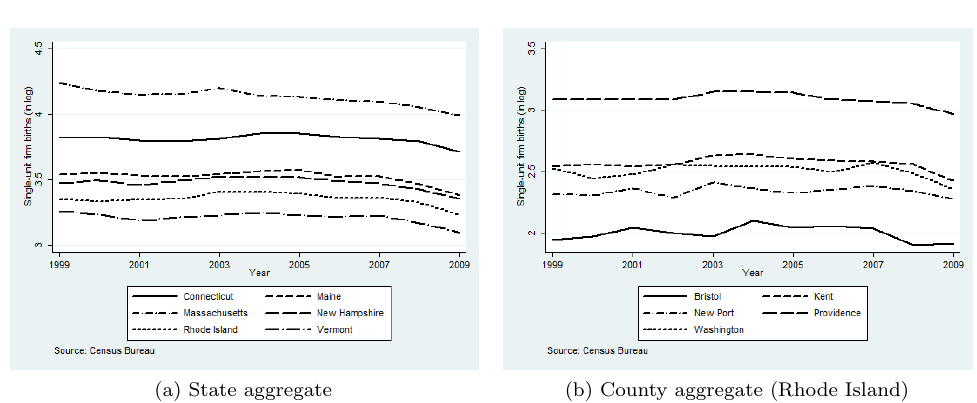
Figure 1: Temporal variation of single-unit firm